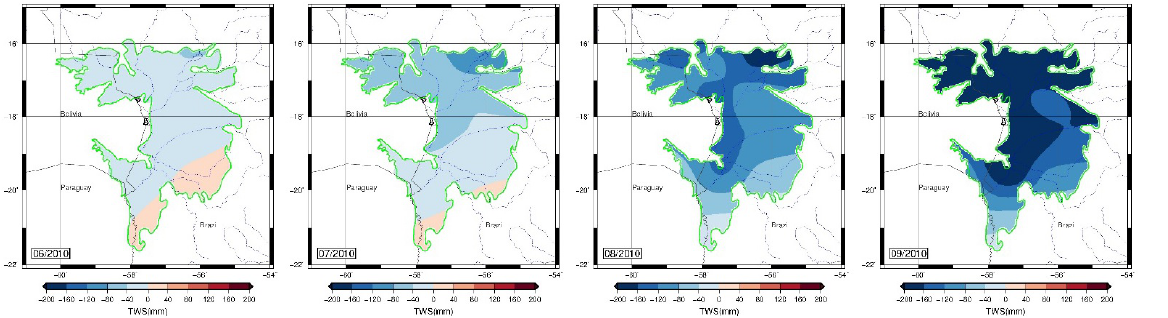
Fig. 3. TWS decrease in the Pantanal area (June to September 2010).